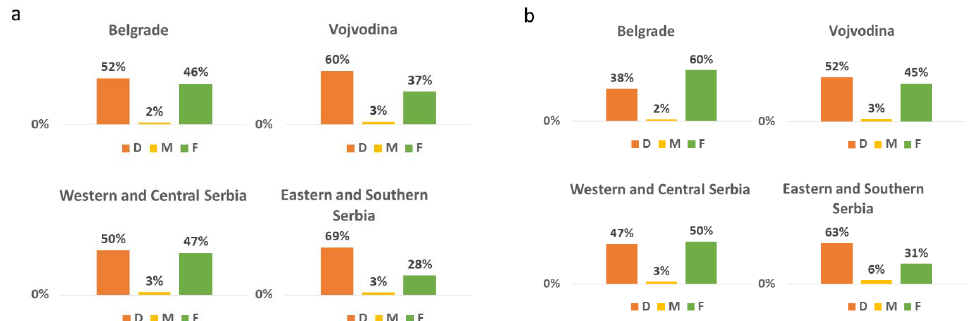
Figure 1. The distribution of DMFT according to the region in ( a ) 12-year-olds and ( b ) 15-year-olds in Serbia. Significant differences in the distribution of D and F components were found between the regions ( p < 0.001, Kruskal–Wallis test).